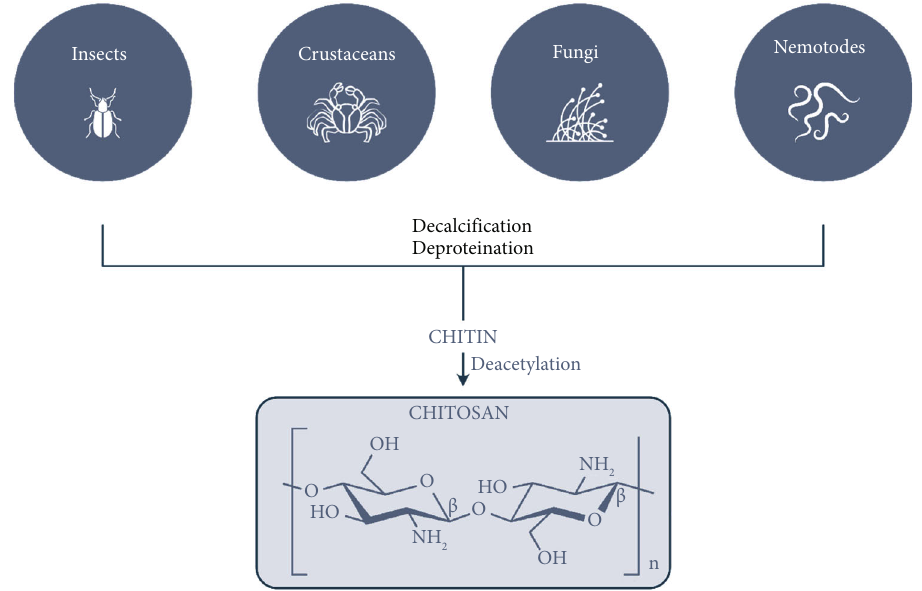
Figure 1: Sources and extraction of chitosan [9].